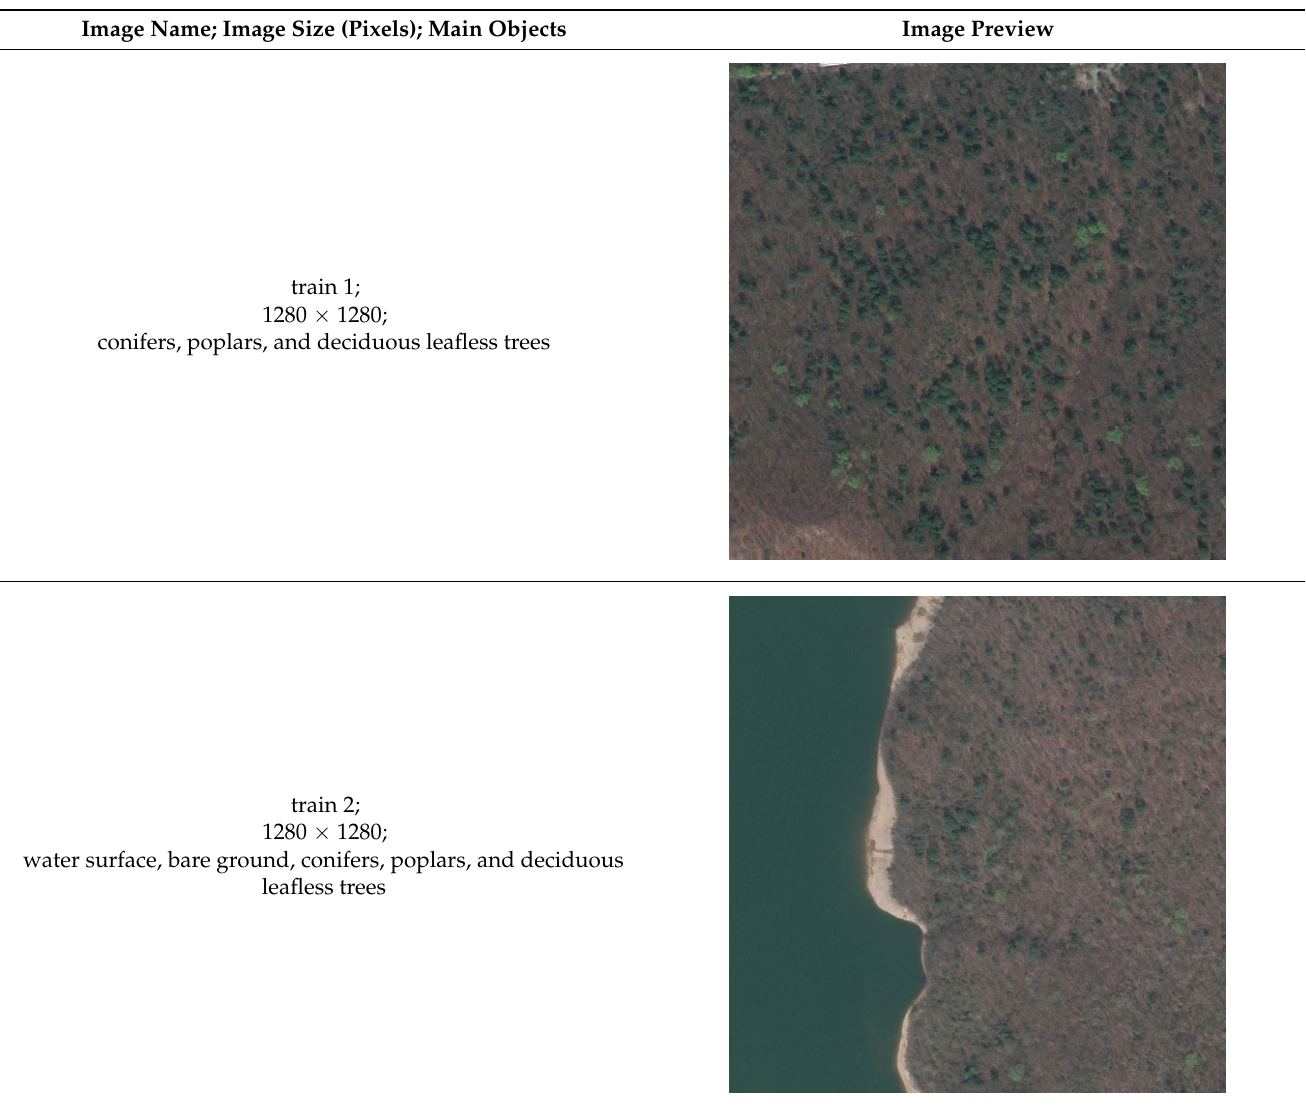
Table A2. Images used for the U-Net-like CNN train, test and validation.